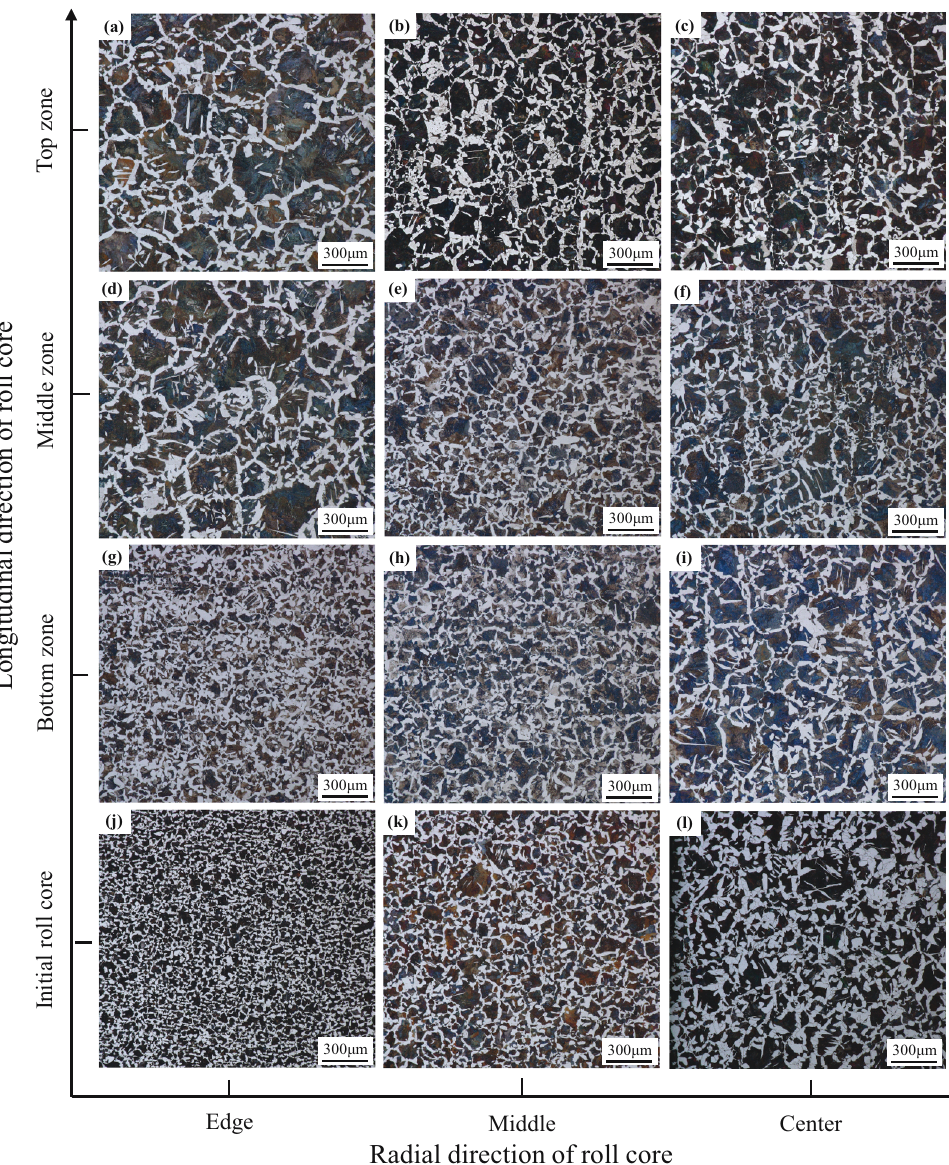
Figure 5: Microstructure of the specimens taken from the roll core ( j – l ) before and ( a – i ) after the ESRC